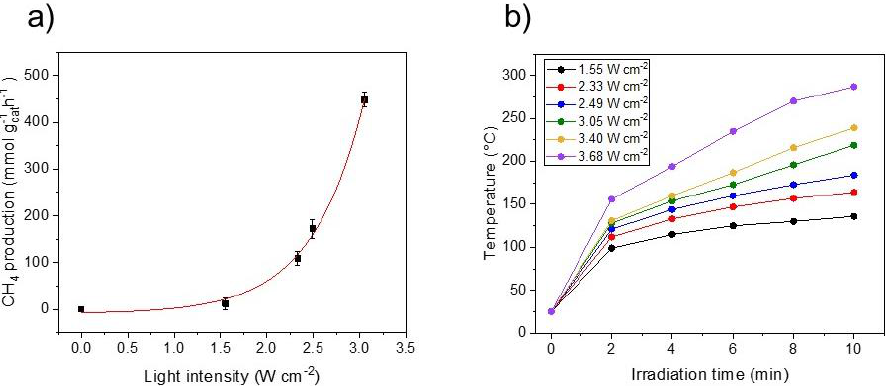
Figure 6. ( a ) Influence of the light intensity on the CH 4 production rate by Ru(2) − TiN tubes. Red line shows the data trend. ( b ) Temperature profile of Ru(2) − TiN tubes under different light intensities. Measurements were repeated 3 times.